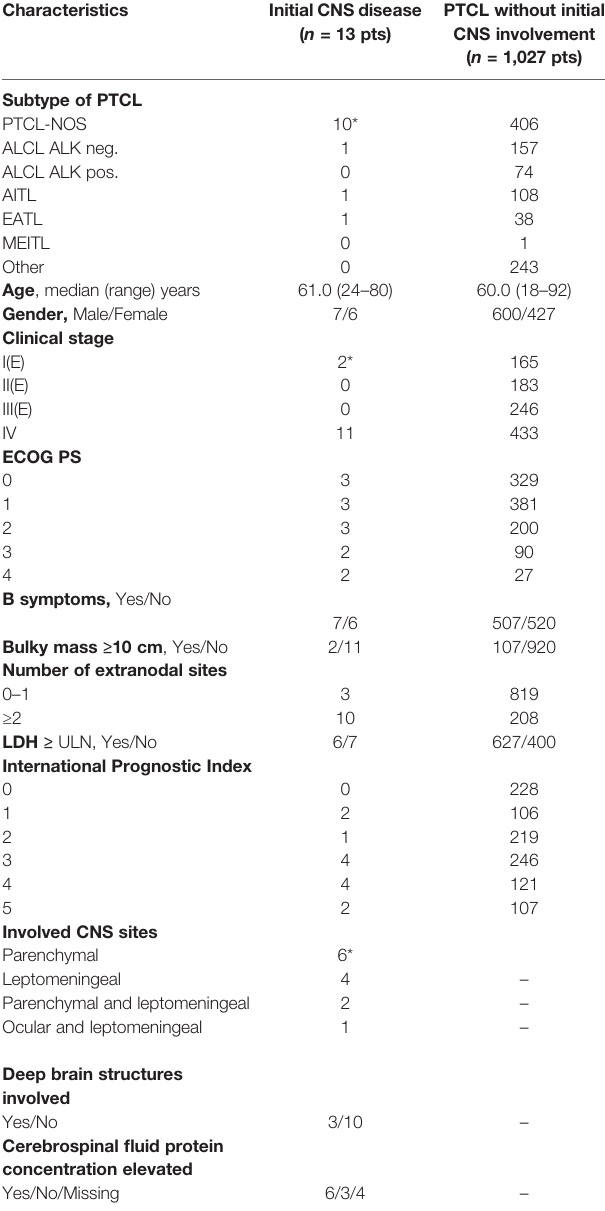
TABLE 1 | Characteristics of patients with initial CNS disease ( n = 13) and all peripheral T-cell lymphomas ( n = 1,040).